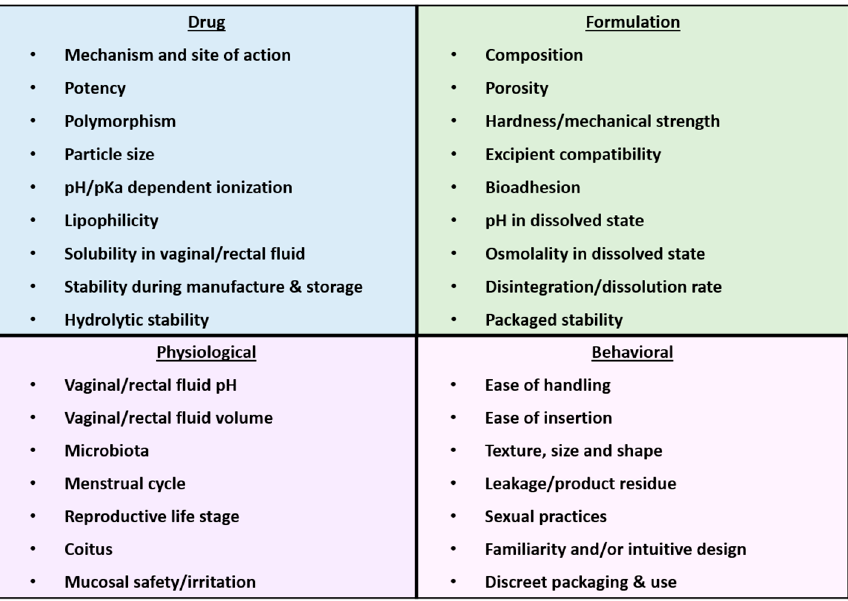
Figure 3. Factors to consider during the design and development process of inserts.